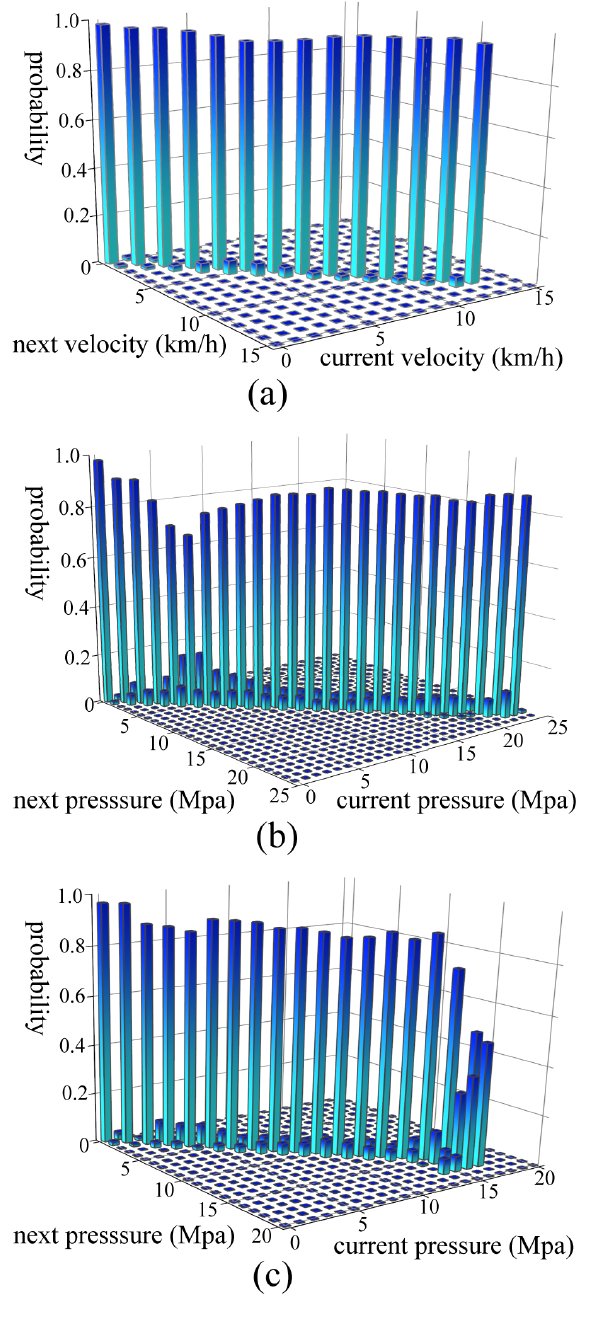
Figure 7. Transition probability for medium coarse gravel. ( a ) Velocity of wheel loader. ( b ) Lift cylinder pressure. ( c ) Tilt cylinder